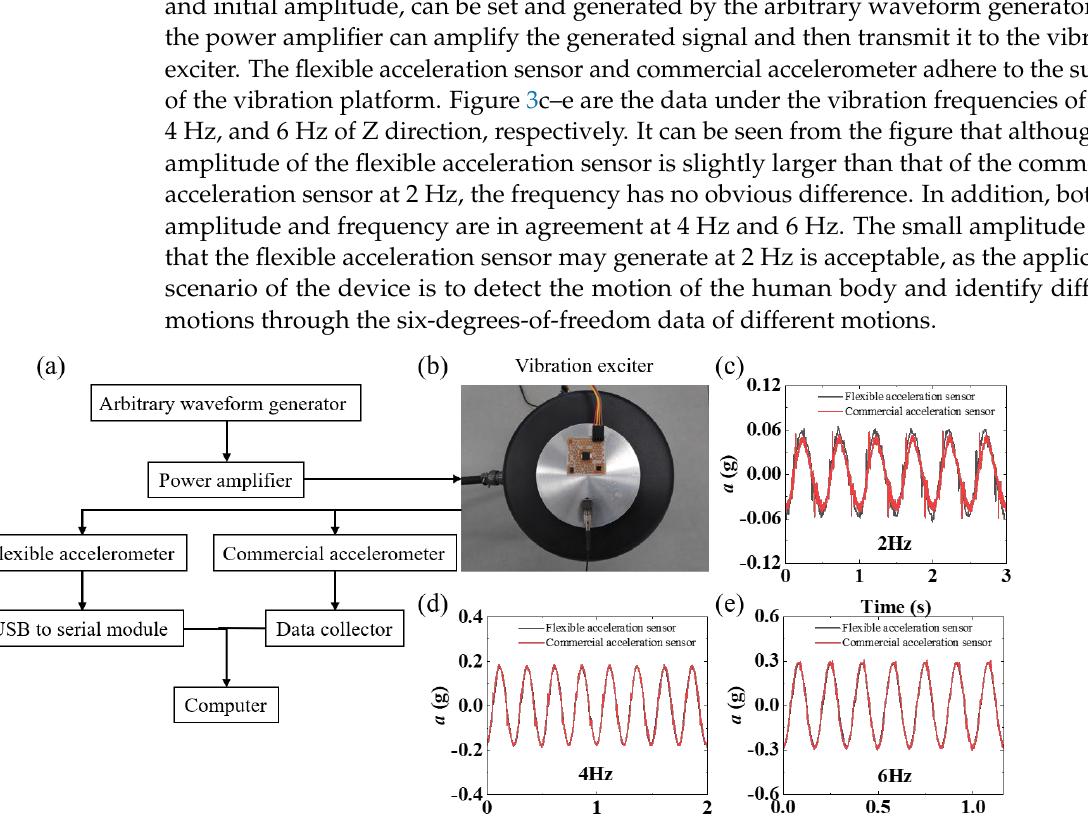
Figure 3. ( a ) Experimental setup for vibration tests, including arbitrary waveform generators, power amplifiers, flexible accelerometer, commercial accelerometer, USB to serial module, data collector, computer, and ( b ) vibration exciter. The Z − direction acceleration measurement data of the flexible accelerometer and commercial accelerometer at ( c ) 2 Hz, ( d ) 4 Hz, and ( e ) 6 Hz, respectively.